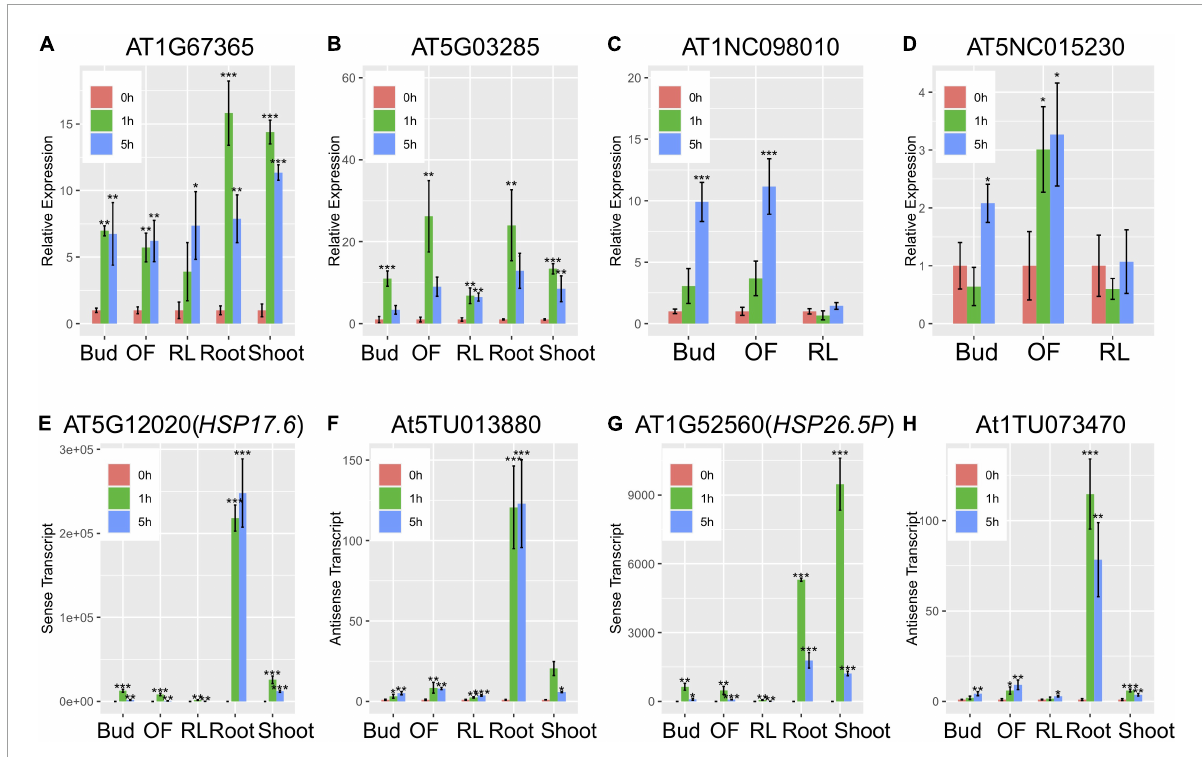
FIGURE2 qRT-PCR for lincRNAs and NAT pairs in different WT tissues. LincRNAs including AT1G67365 (A) , AT5G03285 (B) , AT1NC098010 (C) , and AT5NC015230 (D) . NAT pairs including HSP17.6CII (E) -At5TU013880 (F) and HSP25.6 (G) -At1TU073470 (H) . * P < 0.05, ** P < 0.01, *** P < 0.001 in Dunnett’s two-sided test against 0 h. Error bars indicate SD ( n =